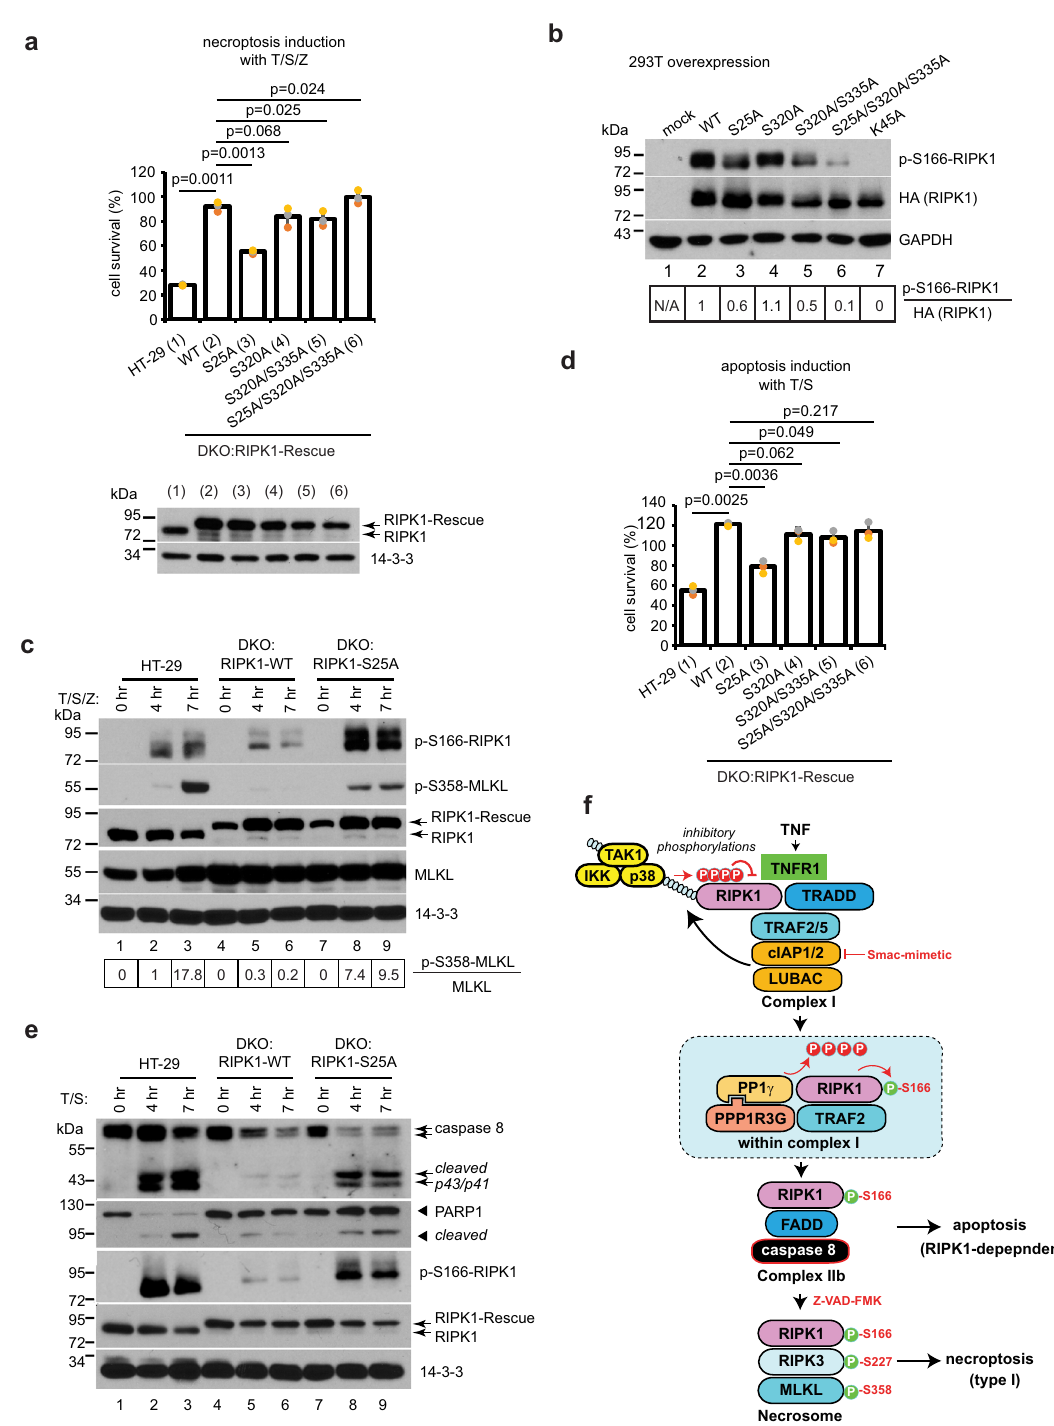
KO and PP1 γ -KD cells, RIPK1 was not activated to autopho- death in PPP1R3G-de fi cient cells, and RIPK1-S320A/S335A sphorylate S166. Second, a PPP1R3G-RAQA mutant that could mutant also restored a signi fi cant amount of cell death (Fig. 6), not bind PP1 γ was not able to restore RIPK1-S166 phosphoryla- suggesting that multiple phosphorylation sites function together to tion and cell death. Furthermore, chemical prevention of inhibi- inhibit RIPK1 activity. It has been suggested that MK2 phos- tory phosphorylations partially restored RIPK1 kinase activity and phorylates S320 of RIPK1 in both complex I and cytosol 36 . Our results show that PPP1R3G/PP1 γ associates with RIPK1 in com- cell death in PPP1R3G-KO cells, suggesting that PPP1R3G/PP1 γ plex I upon T/S/Z treatment (Fig. 4c). In addition, there is holoenzyme counters inhibitory phosphorylations to activate appreciable TRAF2/RIPK1 interaction with PPP1R3G/PP1 γ at RIPK1. Importantly, recombinant PP1 γ directly dephosphorylated basal level (lane 3, Fig. 4b), suggesting that PPP1R3G/PP1 γ might S25, S320, and S335 phosphorylation of RIPK1. Finally, RIPK1- also dephosphorylate cytosolic pool of RIPK1. All these complex S25A mutant largely restored RIPK1 kinase activation and cell NATURE COMMUNICATIONS| (2021) 12:7067